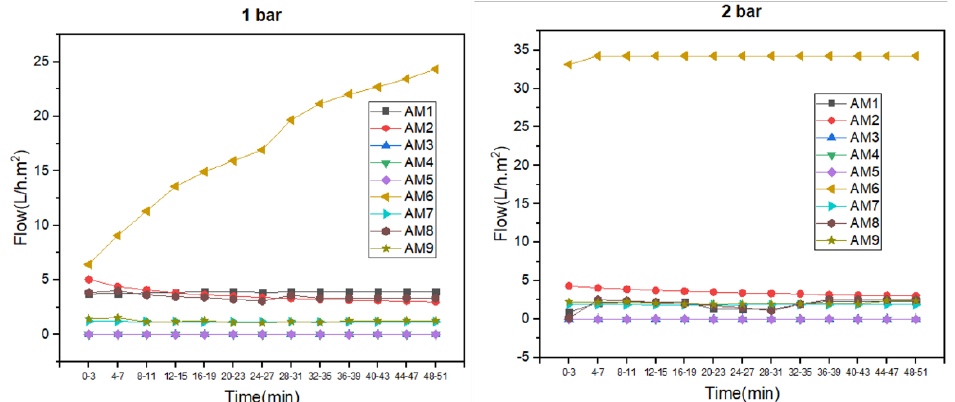
Figure 12. Distilled water flow over time for hollow fiber membranes at pressures of 1.0 and 2.0 bar.